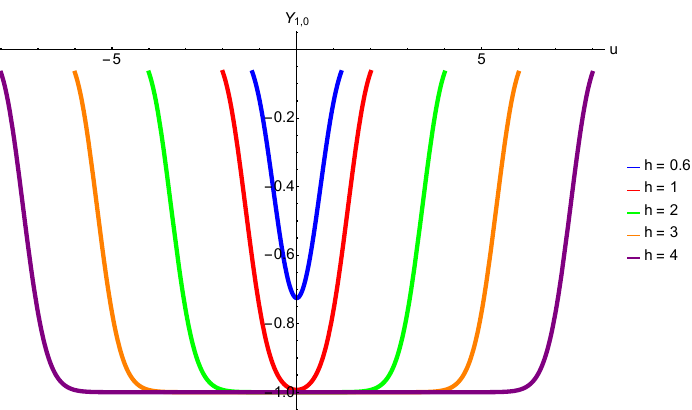
Figure 6 . Plot of Y 1 ; 0 ( u ) for the L = 1 ; S = 1 operator, with u 2 ( (cid:0) 2 h; +2 h ) and di(cid:11)erent values of h . It seems clear that Y 1 ; 0 ( u ) tends to the constant value (cid:0) 1 as the coupling grows.